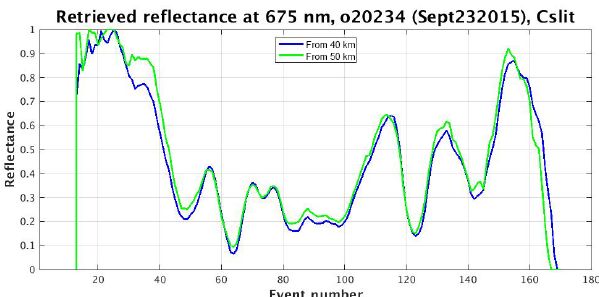
Figure 23. LER retrieved from radiances at h = 40km (blue line) and 50km (green line). Center slit observations from orbit 20234 are used in this example. Again, as noted in Fig. 14, the OMPS LP aerosol extinction retrieval is insensitive to